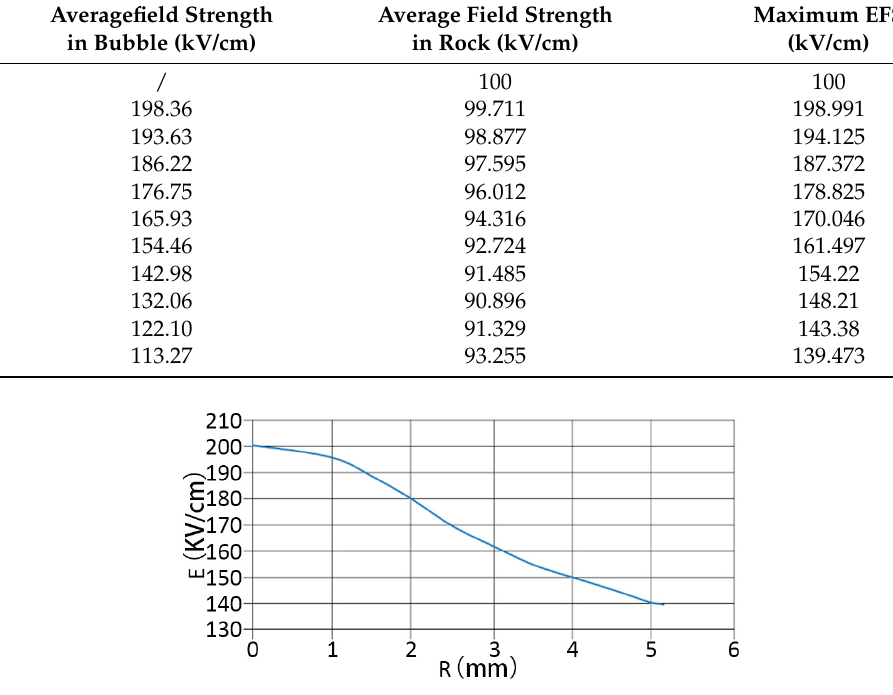
Figure 10. Variation of maximum EFS of rock with radius.